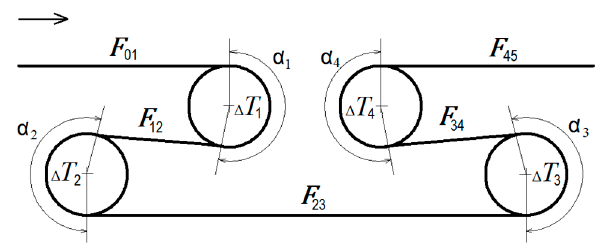
Figure 2. Tensions in the strip passing rolls in the leveler section.